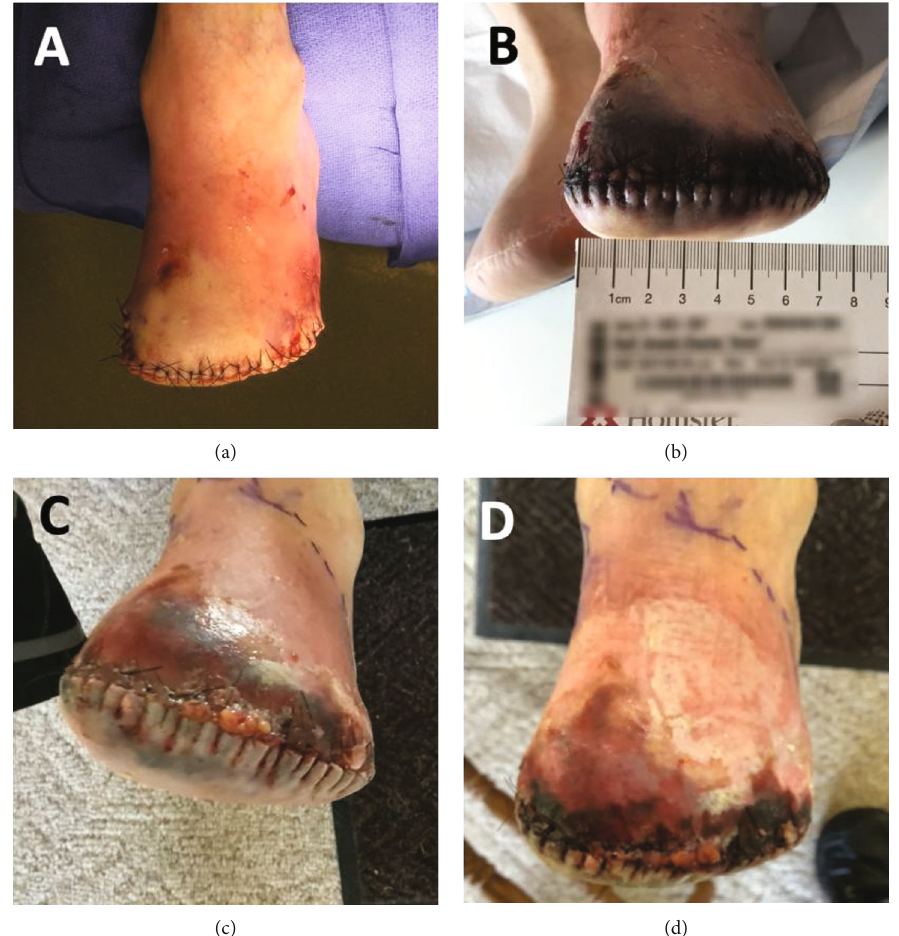
Figure 1: Follow-up pictures of the patient. (a) Intraoperative photograph of the transmetatarsal amputation. (b) ACH follow-up day three after transmetatarsal amputation. (c) The picture was taken on day 2 of the ACH program. (d) The image was taken on day 3 of the ACH program.